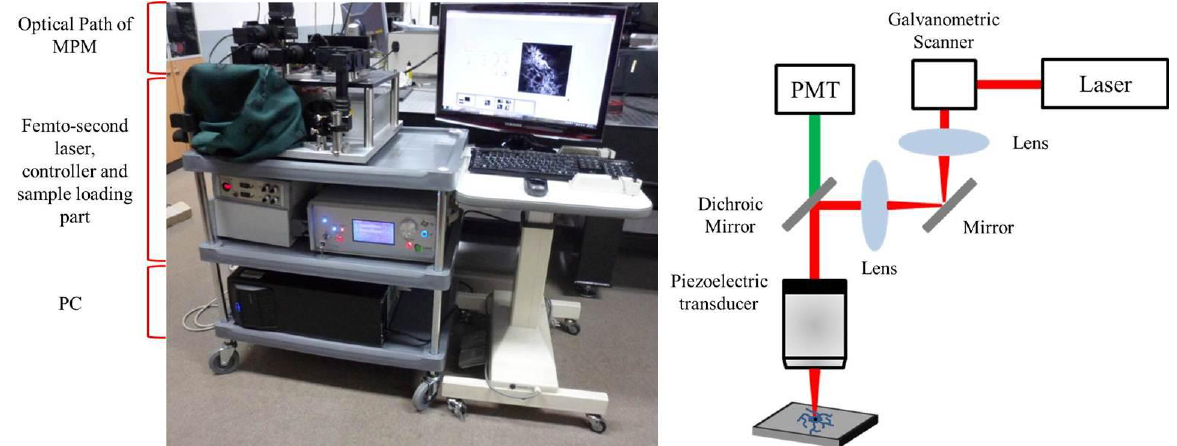
Figure 2. A photograph and the structure of the MPM